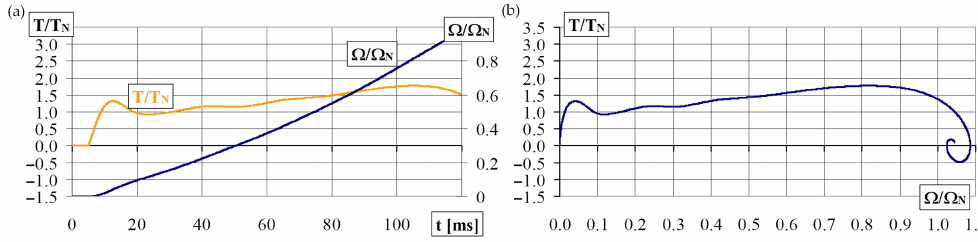
Figure 2. Waveform of electromagnetic torque and rotor speed ( a ), as well as mechanical dynamic characteristics ( b ) of a squirrel-cage induction motor during the direct starting proposed in this